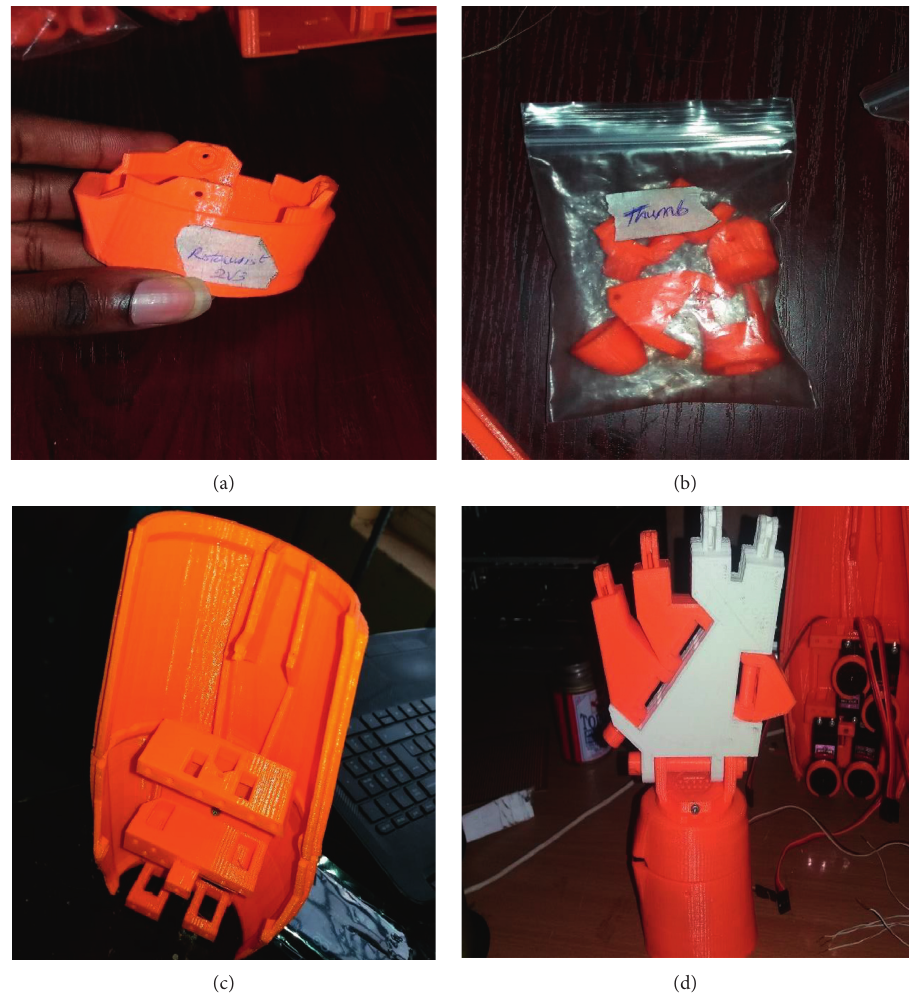
Figure 2: Assembly of the prosthetic hand: (a) wrist component printed, (b) 3D-printed thumb, (c) forearm and servo bed, and (d) wrist and hand assembly.